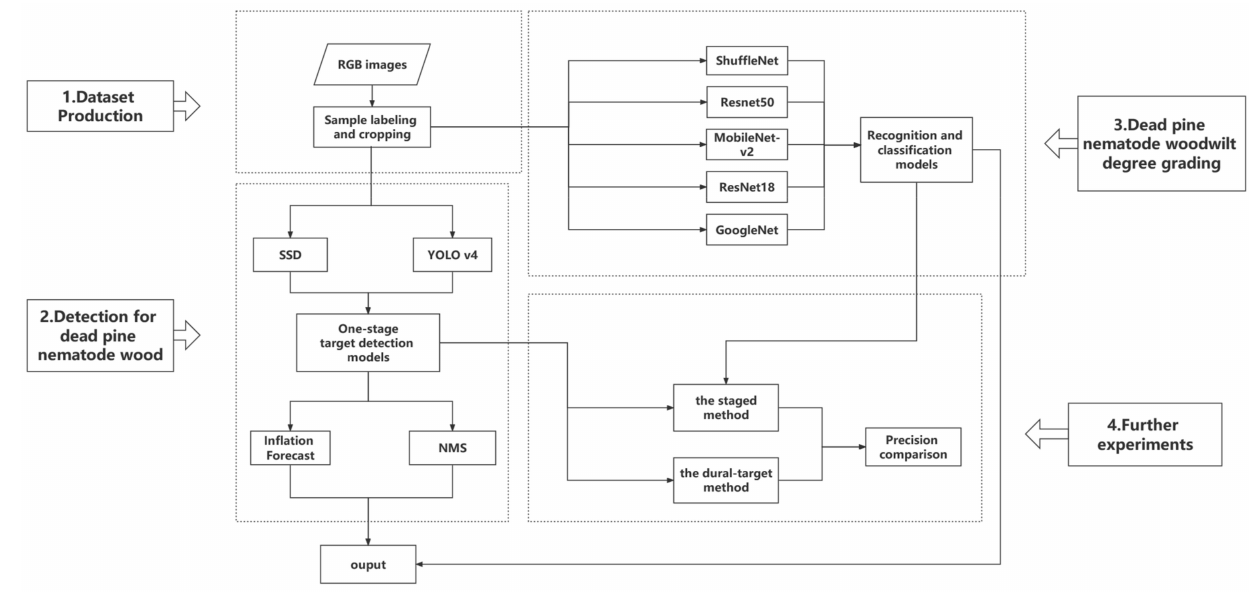
Figure 3. Technology